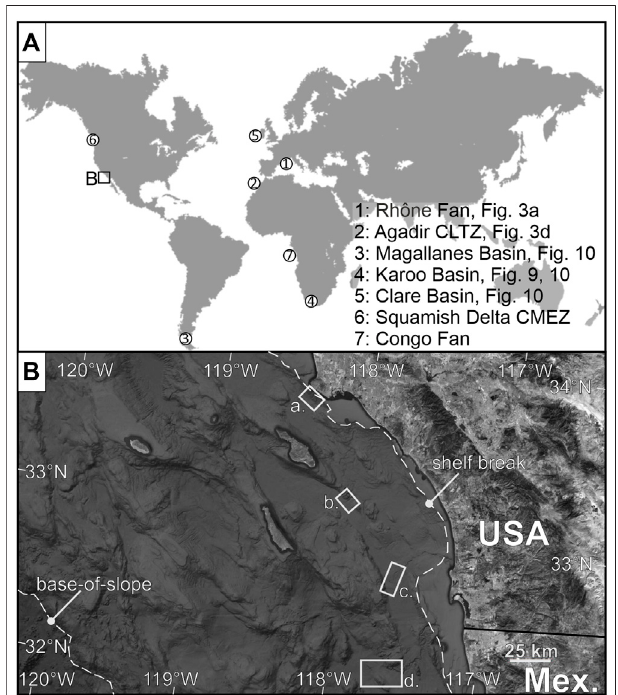
FIGURE 2 | (A) and (B) Location maps of the channel mouth settings reported here. (B) Onshore and offshore map from GoogleEarth to highlight the locations of study areas offshore Southern California; (a) plunge pool sites (Lee et al., 2002; Figure 5 ); (b) the San Gabriel channel and fan (Maier et al., 2018; Figure 4 ); (c) the La Jolla Fan (Maier et al., 2020; Figure 4 ); and, (d) the Navy Fan (Carvajal et al., 2017; Figure 4 ). Note that all the sites are located on a topographically complex continental slope. Mex. =